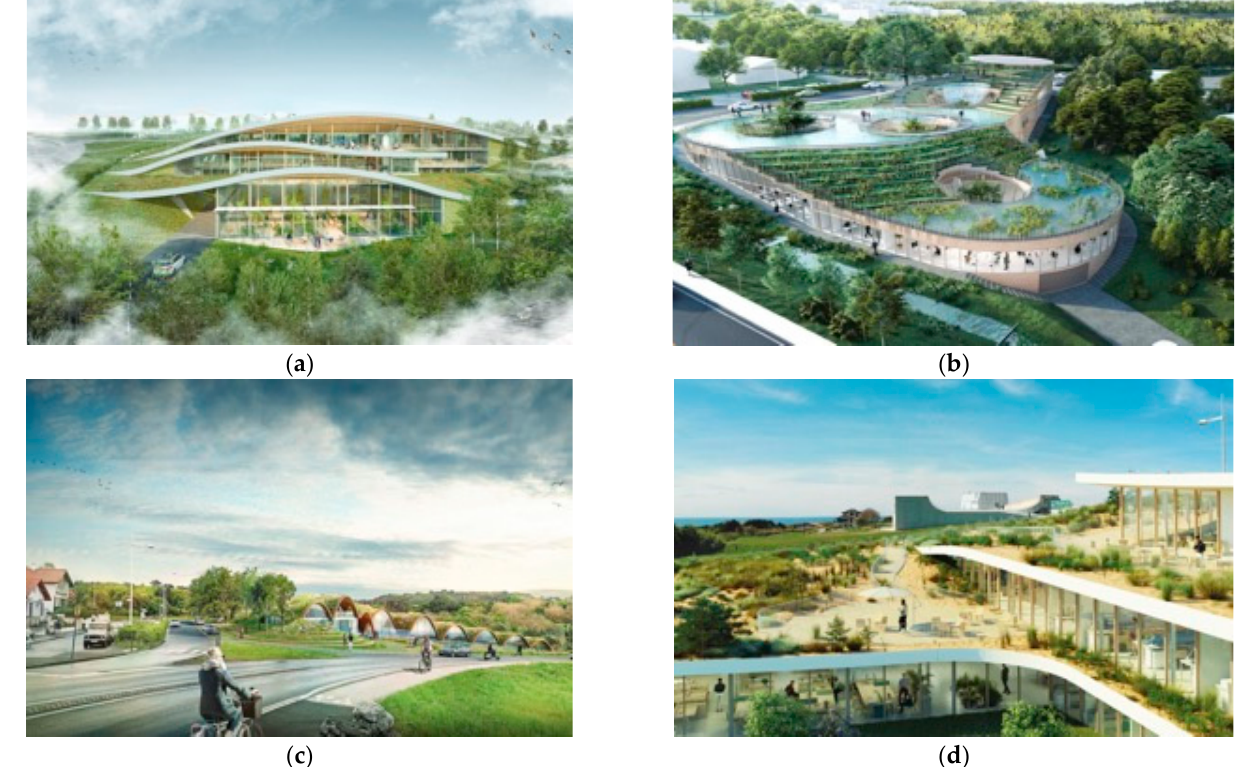
Figure 3. Proposed projects for the Marine Biomimetic Centre of Biarritz, 2019 ( a ) winning project © Arotcharen architecture studio, ( b ) Estran © Bechu & Partners, ( c ) © Tangram & Tangram Lab, ( d ) © ChartierDalix.